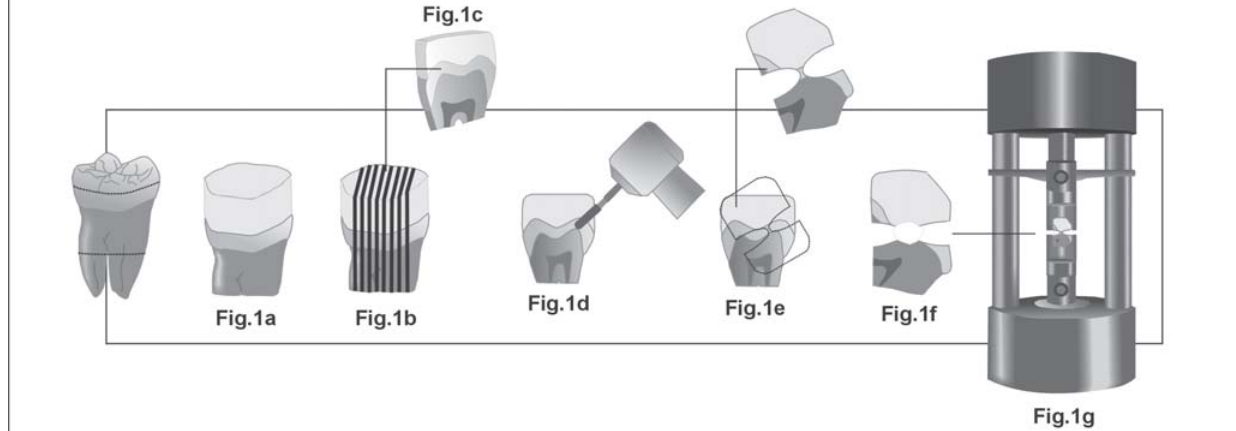
FIGURE 1- Schematic representation of specimen preparation (1a- composite placed over enamel oclusal surface to facilitate the microtensile bond strength test; 1b- tooth vertically sectioned into some slabs; 1c- 0.7-mm thick slab; 1d- slabs were trimmed with a fine diamond bur; 1e- specimen prepared after trimming and the enamel structure to be tested was prepared from the enamel located at the internal slope of the buccal cusp; 1f- bleaching gel applied on trimmed enamel area; 1g- treated specimen fixed to the “grips” of microtensile test